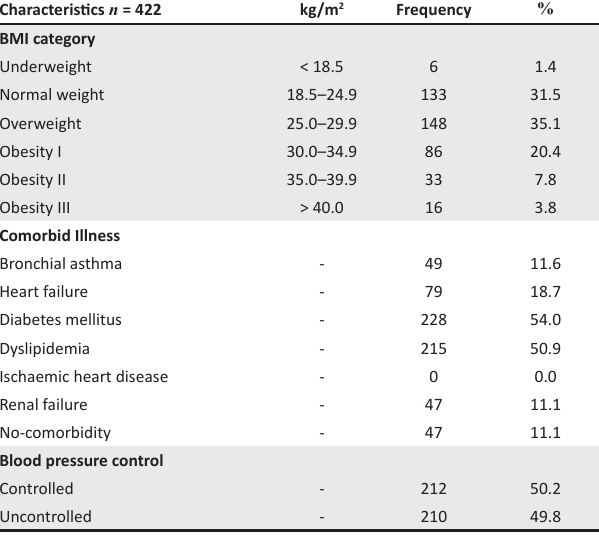
TABLE 2: Body mass index, comorbidity and blood pressure control.